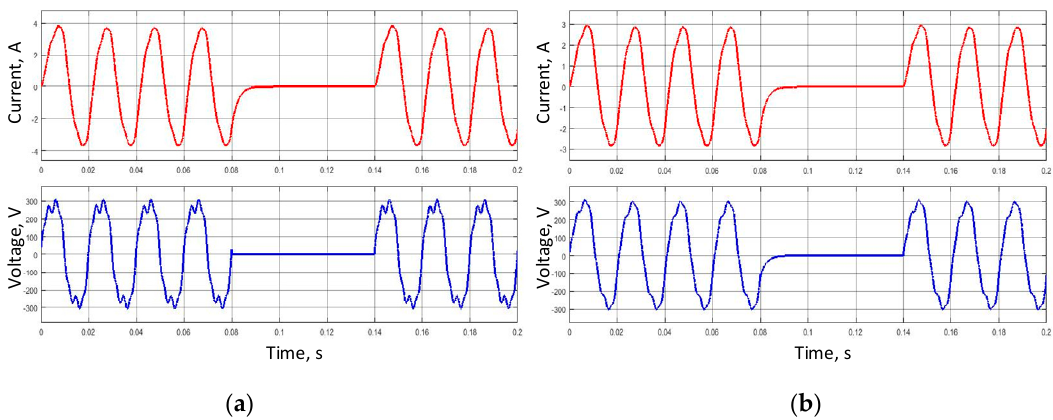
Figure 3. Modeling a circuit on a classic transformer: ( a ) the current and voltage on the primary winding of a classical transformer; and ( b ) the current and voltage on the load for a classical transformer.